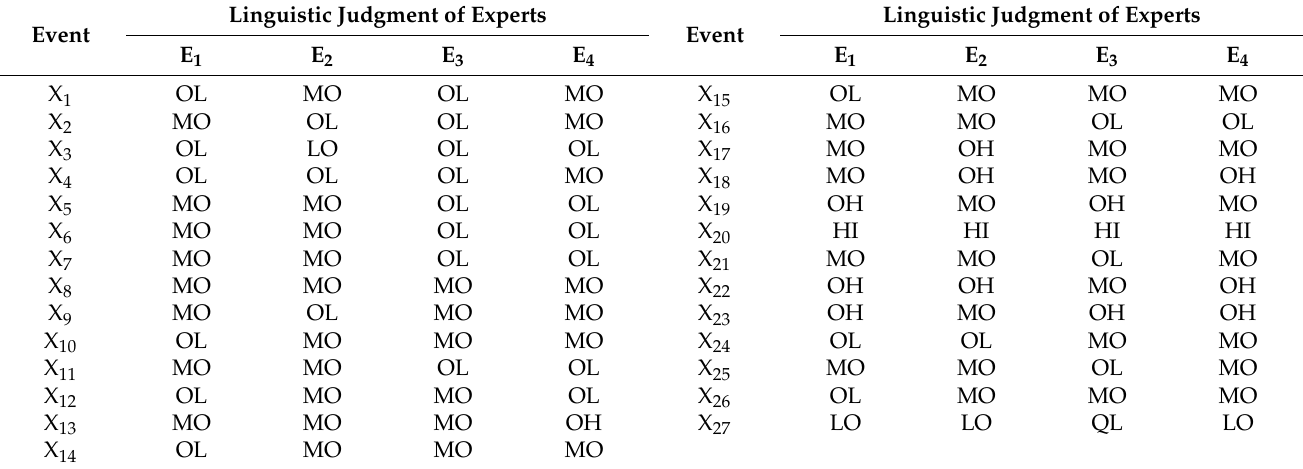
Table 7. Experts’ opinions on root events of the BN for the gasifier failure.